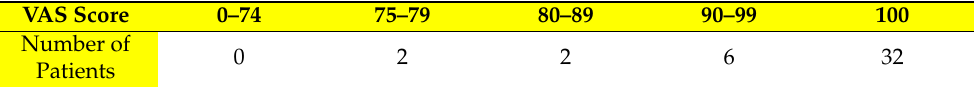
Table 3. Patient satisfaction. Visual analog scale (VAS) was used to assess patient satisfaction: 100 represented the best possible aesthetic outcome and 0 was the